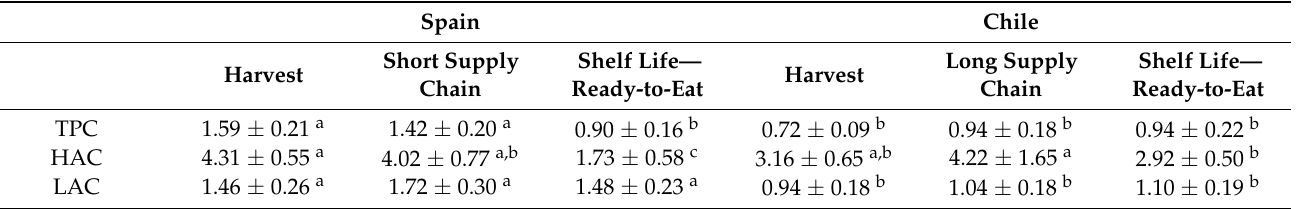
Table 3. Total phenolic compounds, in vitro hydrophilic (HAC), and lipophilic antioxidant capacity (LAC) in Hass avocado from two countries (Spain and Chile) at harvest, after short and long-supply chain and at the ready-to-eat stage. Spain Chile Short Supply Shelf Life— Long Supply Shelf Harvest Harvest Chain Ready-to-Eat Chain